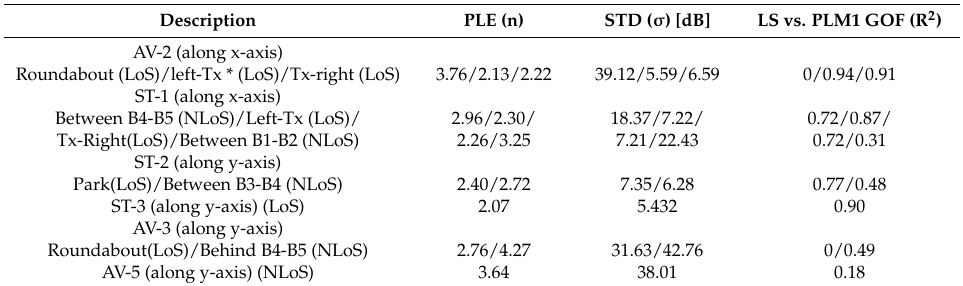
Table 3. Path loss exponent (PLE) and standard deviation